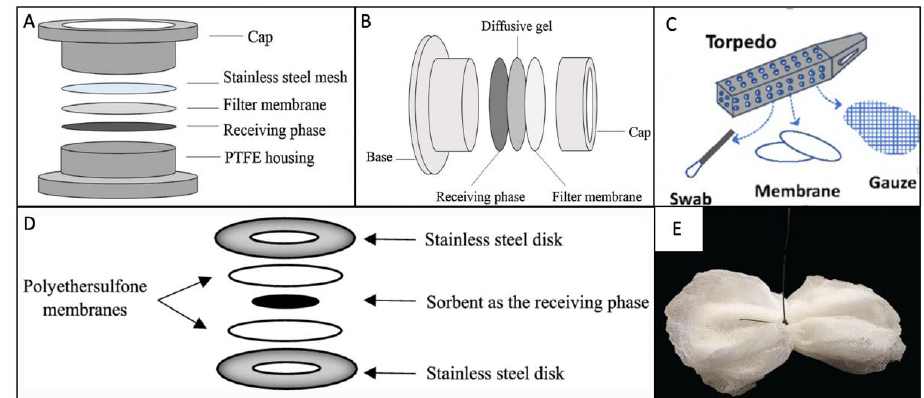
Figure 1. Passive sampling devices that have been utilised in wastewater surveillance. ( A ) Representation of Chemcatcher passive sampler configuration comprising of outer housing units containing a stainless steel mesh, filter membrane and receiving phase [110]; ( B ) Representation of a Diffusive Gradients in Thin Films (DGT) passive sampler comprising of outer housing units holding together a filter membrane, diffusive gel and receiving phase [110]; ( C ) Configuration of a 3D torpedo-style passive sampling device designed for sampling of SARS-CoV-2 containing swabs, medical gauze and membrane filters [101]; ( D ) Representation of a Polar Organic Chemical Integrative Sampler (POCIS) configuration comprising of a receiving phase sorbent between two polyethersulfone (PES) membranes held together by two stainless steel disks [111]; ( E ) The Moore Swab comprised of medical gauze pads held together with string [112].